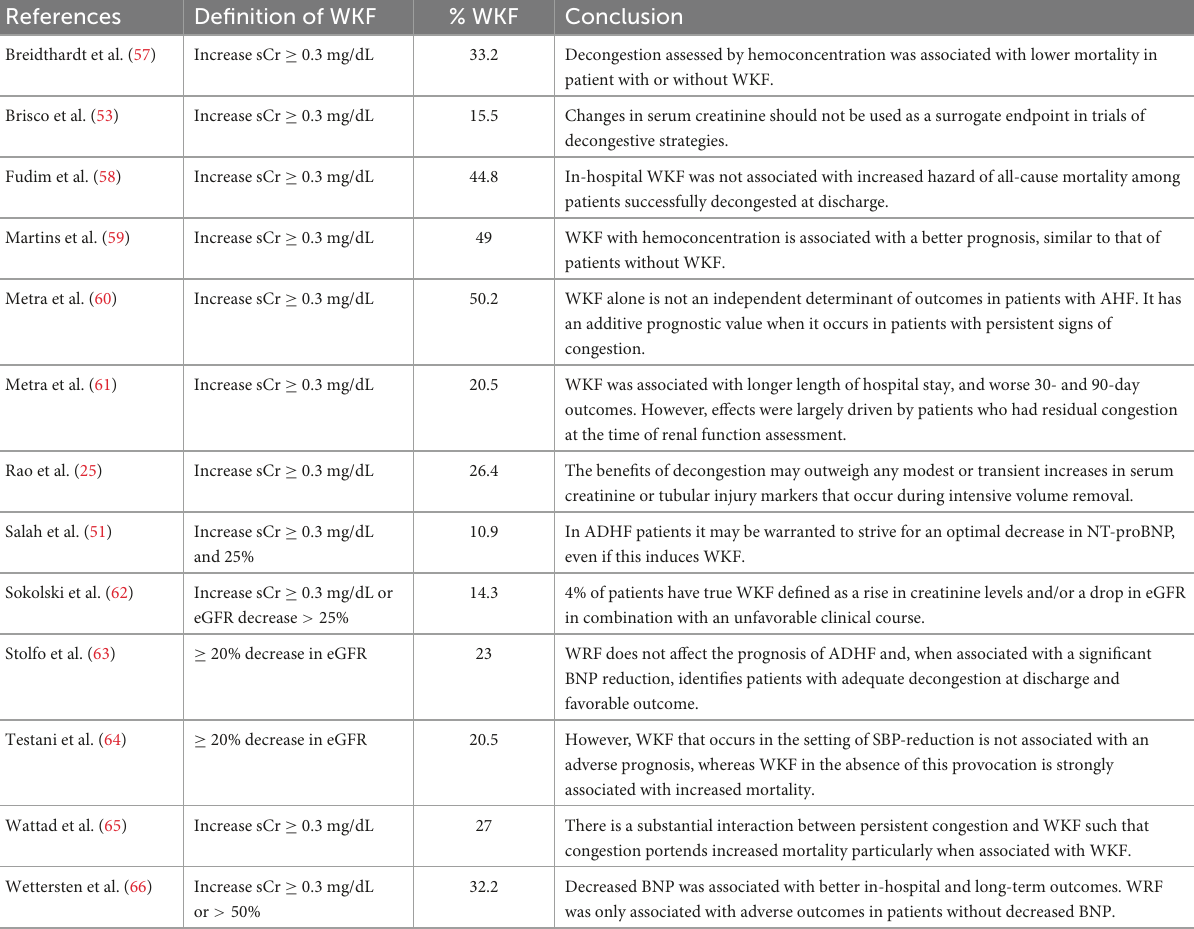
TABLE 1 Definitions of worsening kidney function, its frequency, and main outcomes during decongestion in acute decompensated heart